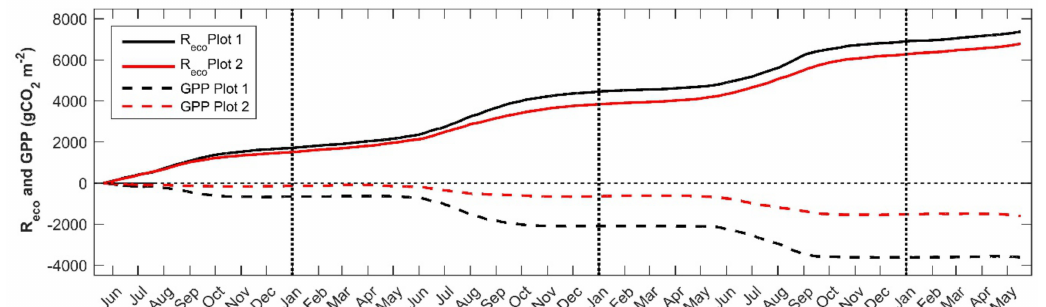
Figure 10. Ecosystem respiration and Gross Primary Productivity ( GPP ) in gCO 2 m − 2 from May 2010 through May 2013 on plot 1 ( R eco —black line, GPP —black dashed line) and plot 2 ( R eco —red line, GPP —red dashed line). Vertical dashed lines mark the start of a new